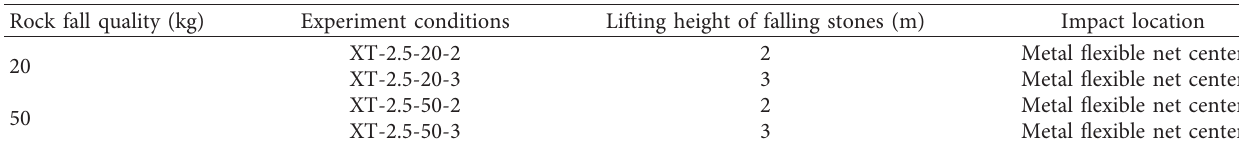
Figure 3: The slant antirock fall impact experiment. Table 1: The conditions of slant antirock fall impact